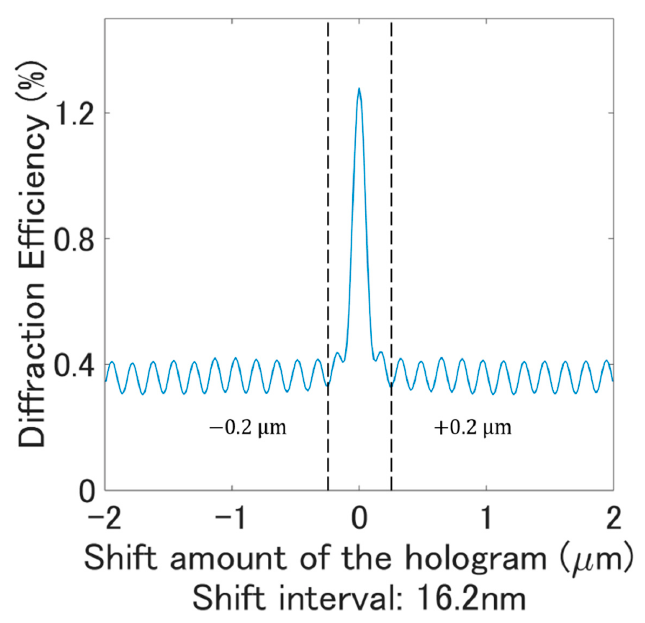
Figure 5. Shift selectivity of the surface collinear holographic memory.